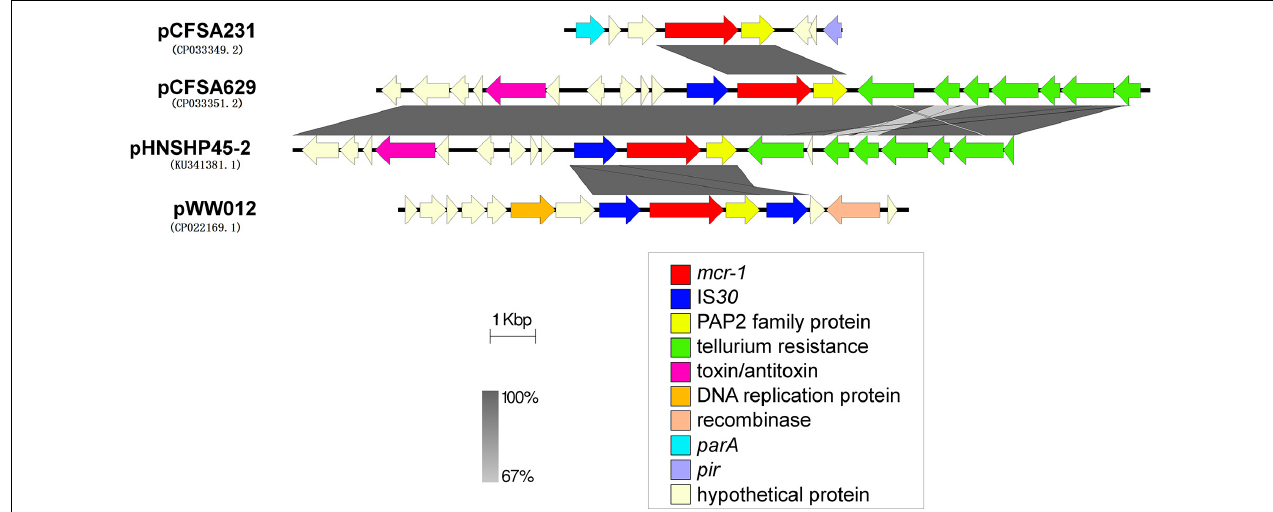
FIGURE 5 | Genetic environments related to mcr-1 gene in bacterial plasmids. The figure was generated by Easyfig (v2.2.2). Plasmids marked with “pCFSA” were carried by two mcr-1 positive Salmonella isolates in this research, and plasmid pWW012 belonged to a previous research in our lab (accession number: CP022169), while pHNSHP45-2 (accession number: KU341381) belonged to Escherichia coli strain SHP45, which is the first isolate reported harboring mcr-1 gene. Confirmed and putative open reading frames (ORFs) are indicated by block arrows and their orientations with different colors, and arrow size is proportional to the predicted ORF length. mcr-1 gene is indicated by a red arrow, while genes encoding mobile elements (insertion sequence, IS) are indicated by blue arrows. Regions of homology between the plasmids ranging from 67 to 100% are indicated by the graded shaded regions between